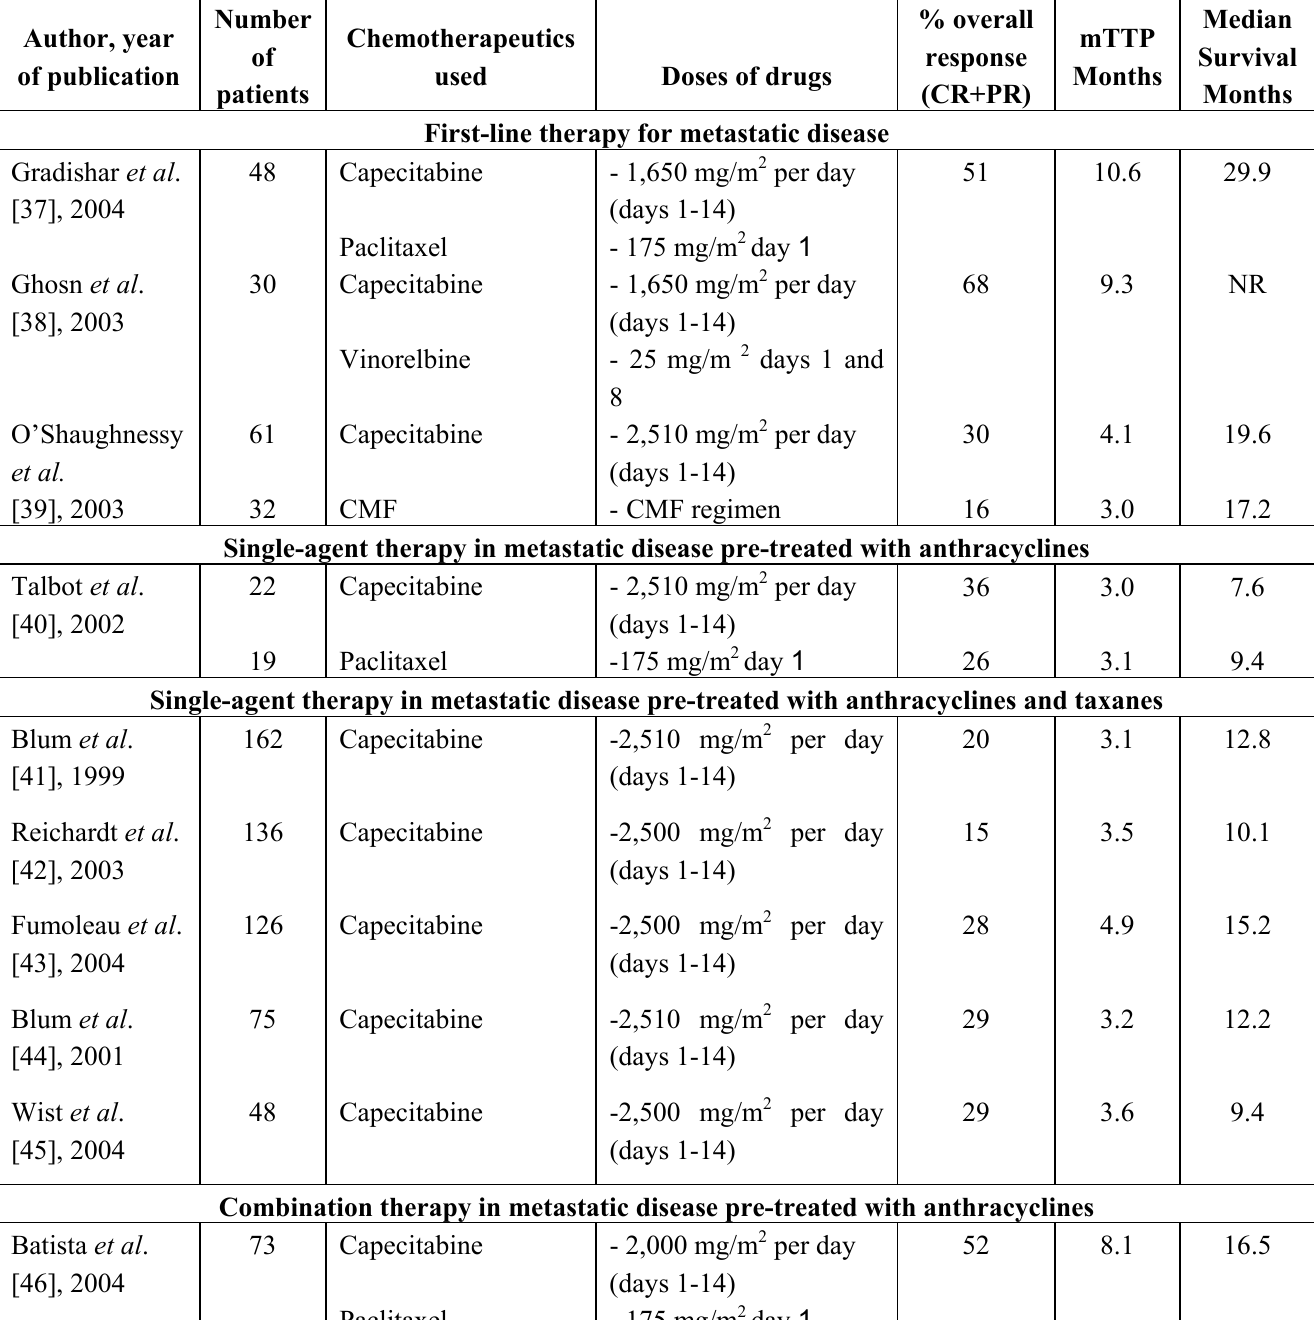
Table 4. Phase II trials of Capecitabine alone or in combination therapy in patients with advanced or metastatic breast